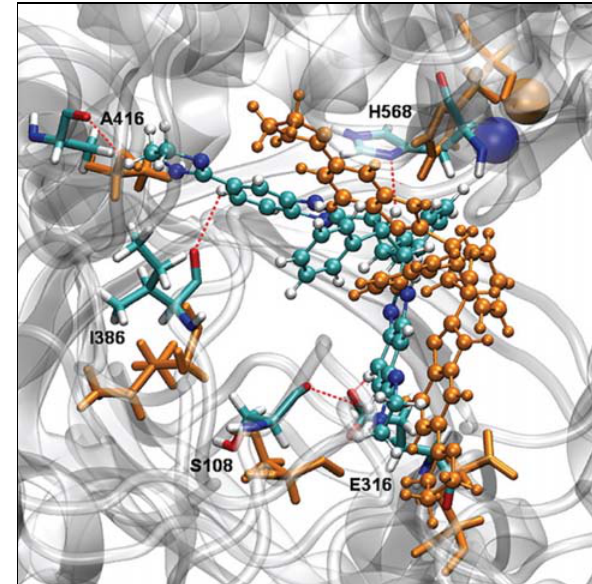
Fig. 6. Overlay of inhibitor 1 orientation in the DPP III binding si- te before (orange) and after short-time heating (colored by the atom type). The five red dotted lines represent the hydrogen bonds bet- ween the inhibitor and the residue Ser108, Glu316, Ile386, Ala416, and His568. Zn 2+ is shown as a